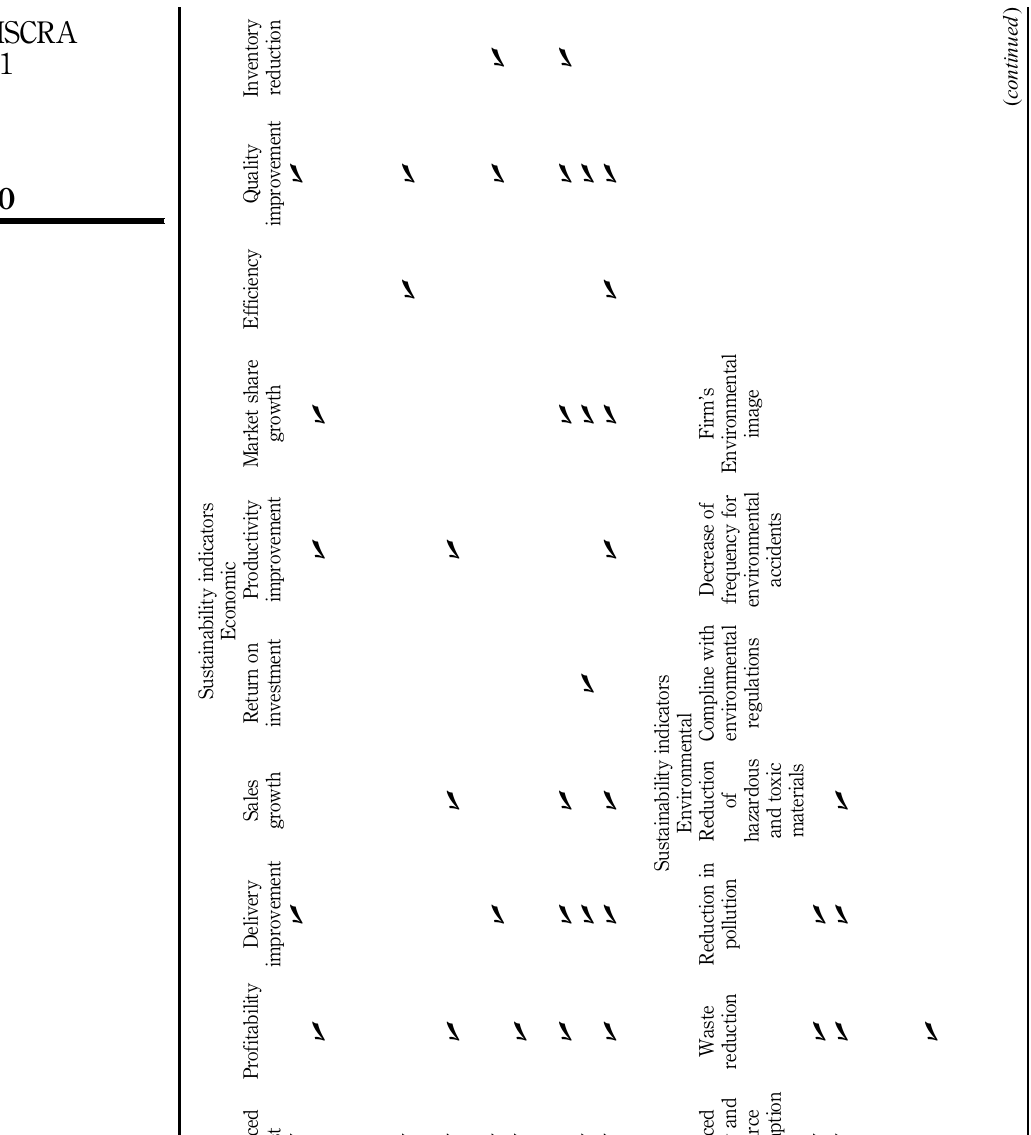
Table III. Sustainability indicators (RL and sustainability performance in the perspective of